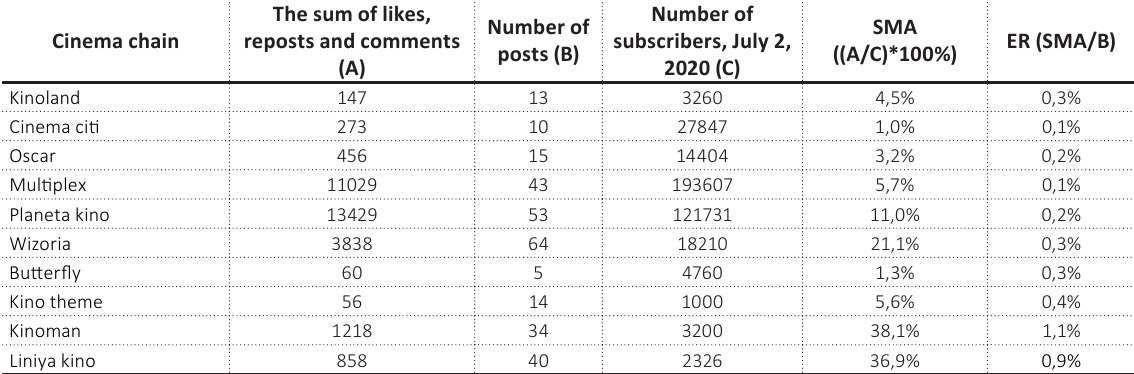
Source: Developed by